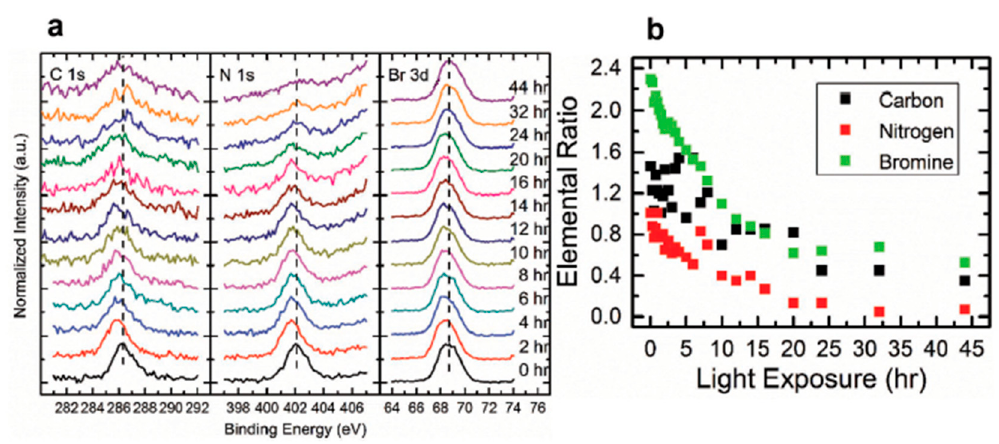
Figure 12. ( a ) A stack plot of the C 1s, N 1s, Br 3d 5/2 core levels of cleaved MAPbBr 3 single crystal with increasing light exposure. ( b ) Elemental ratio change for C, N, and Br under light exposure. From Ref. [62] with permission.